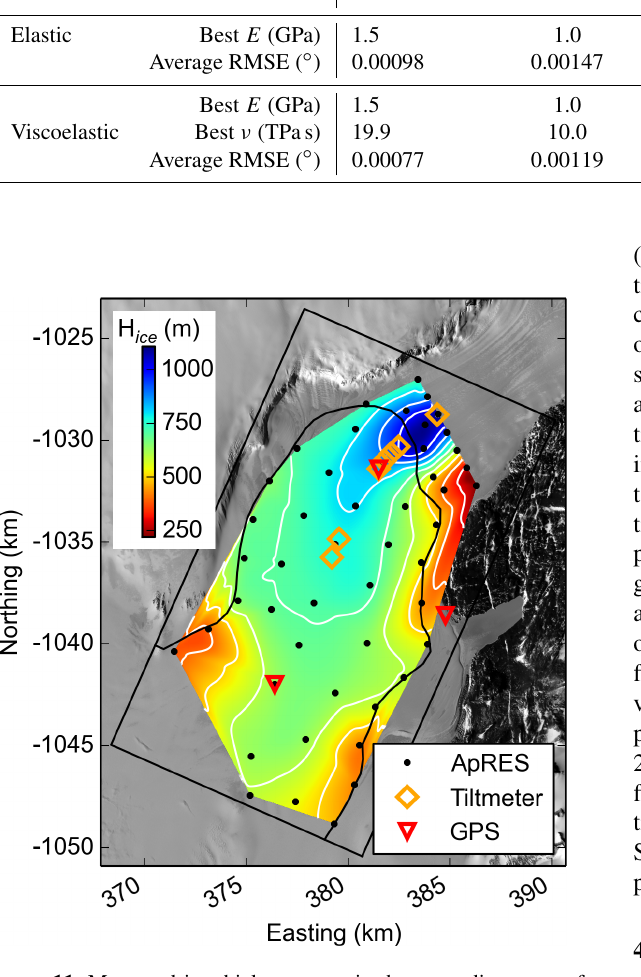
Figure 11. Measured ice-thickness map in the grounding zone of the Darwin Glacier. Black dots show locations of high-precision ApRES measurements. Orange rectangles mark seven tiltmeter sen- sors that are oriented along the glacier’s centerline. Red triangles show locations of GPS stations on the moving ice (Shirase and Hillary) and the location of the GPS base station on stagnant ice which is used for differential correction of the measurements. White contours correspond to a 100m change in interpolated ice thickness. The map background is contrast-stretched Landsat 8 panchromatic